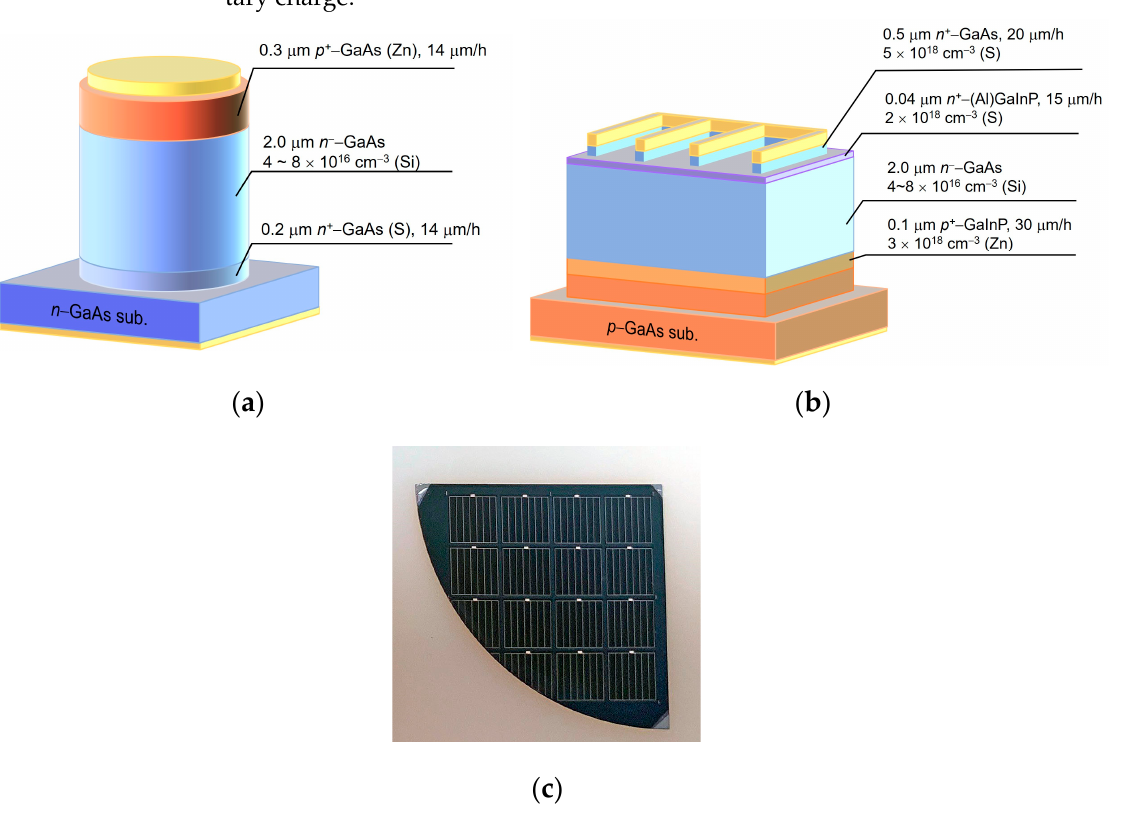
Figure 1. Schematic of the growth chambers in the custom-built hydride vapor phase epitaxy (HVPE) reactor. Dashed arrows indicate the direction of movement of the mechanical transfer arm between the preparation chamber and each growth chamber.